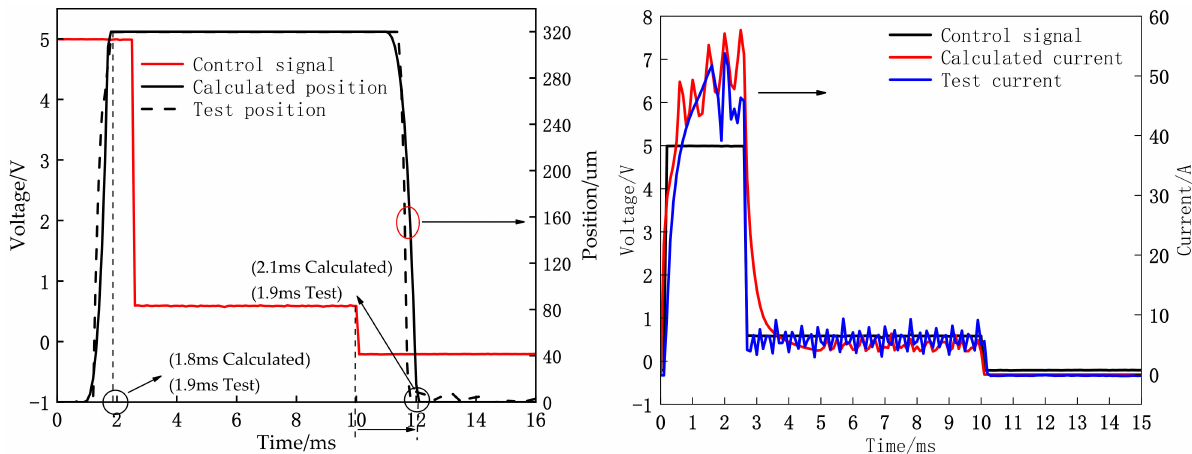
Figure 10. Comparison of calculated and experimental